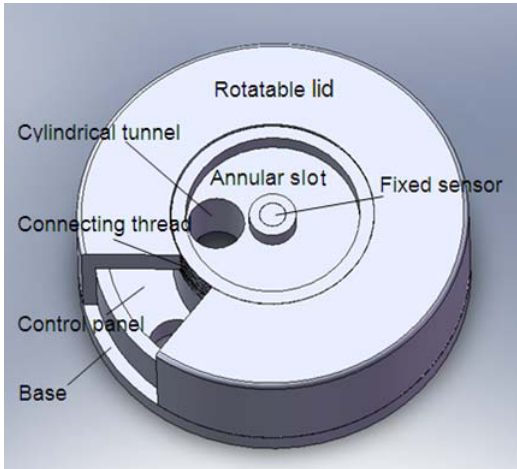
Figure 1. Installation base of the